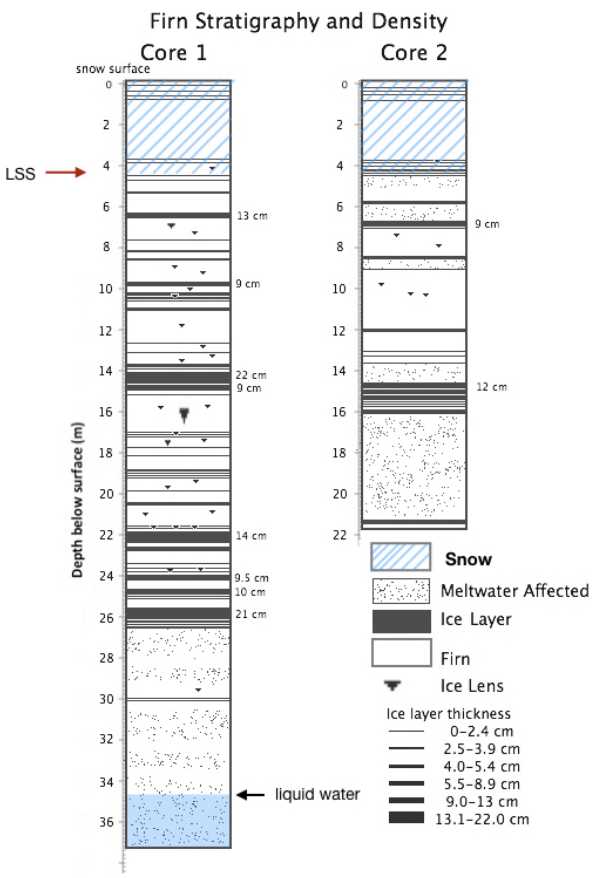
Figure 3. Stratigraphy of the cores collected in May 2018. LSS is the last summer surface at 4.2m, the boundary between seasonal snow above and firn below. Ice layer thicknesses were classified in the legend by thickness distribution. Note that the ice layers in the first several metres of the core are interpreted as wind